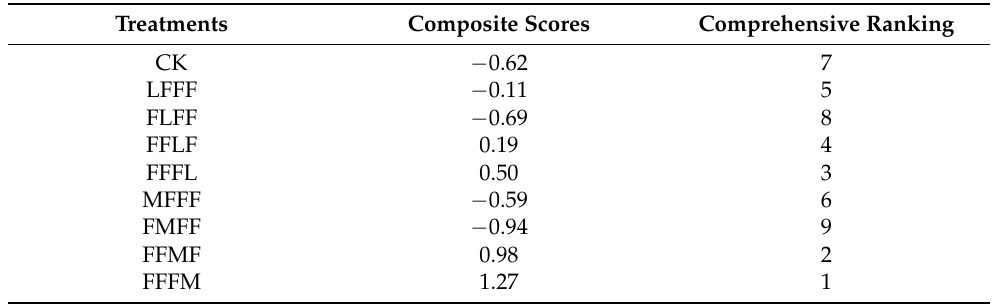
Table 5. Comprehensive evaluation of quality traits of pumpkins in different deficit irrigation treatments.